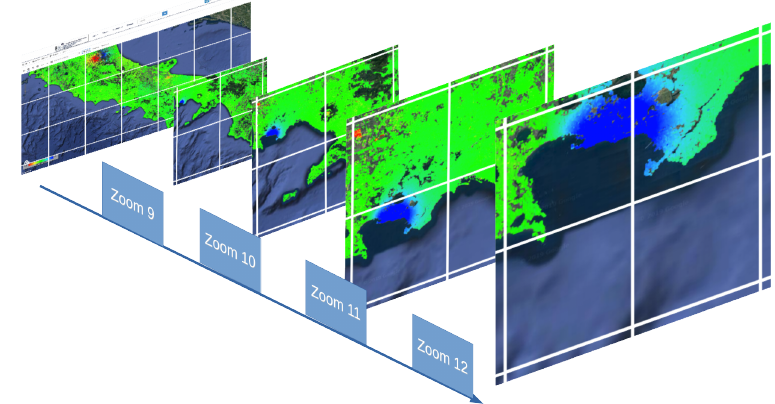
Figure 8. Pictorial representation of the pre-build tiles for different levels of